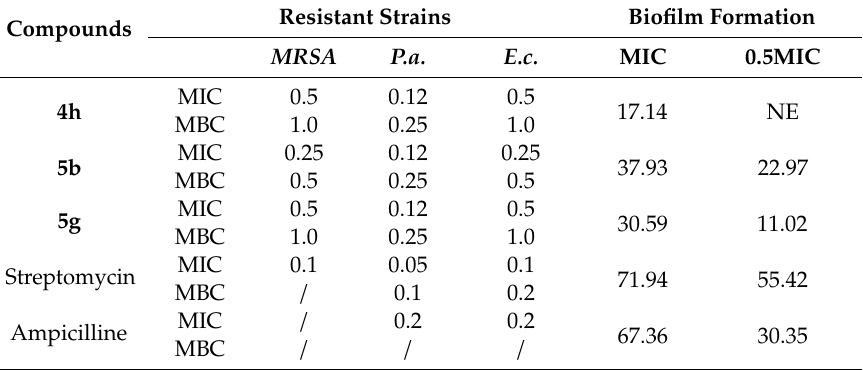
Table 2. Antibacterial activity against resistant strains and e ff ect on biofilm formation(mg / mL).